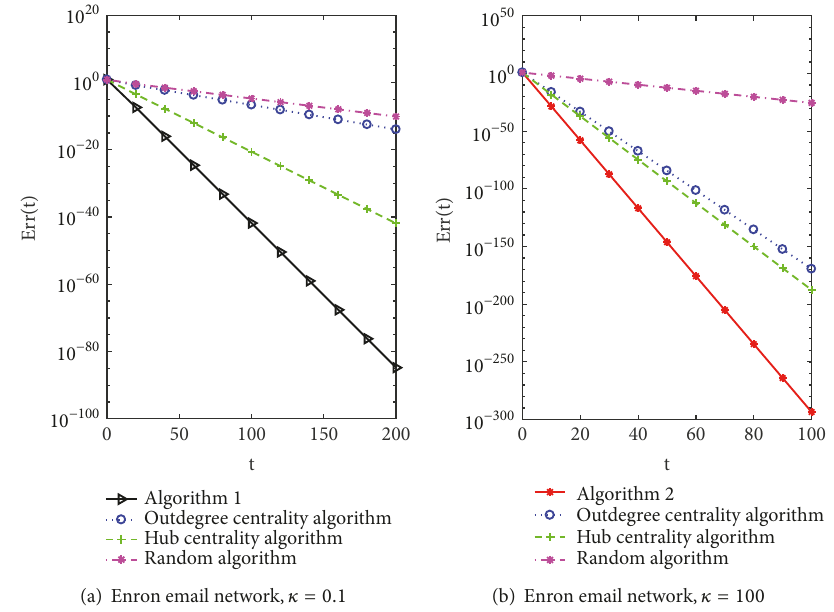
Figure 4: Dynamics of Err (𝑡) with different pinning algorithms. The pinned node number is fixed to be 6.